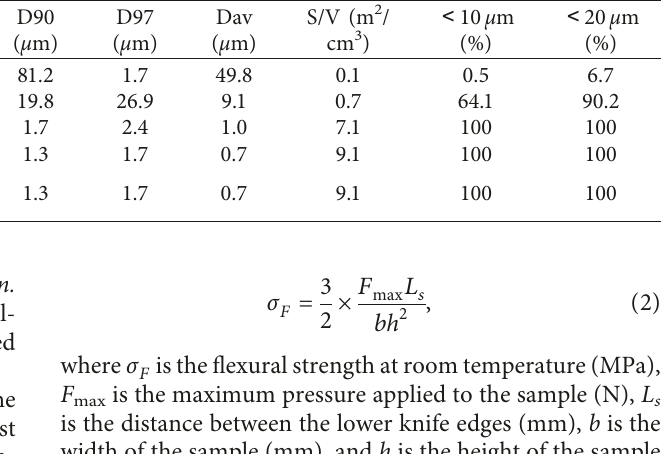
Table 2: Characteristic parameters of particle size distribution before and after ball milling of raw materials. Characteristic